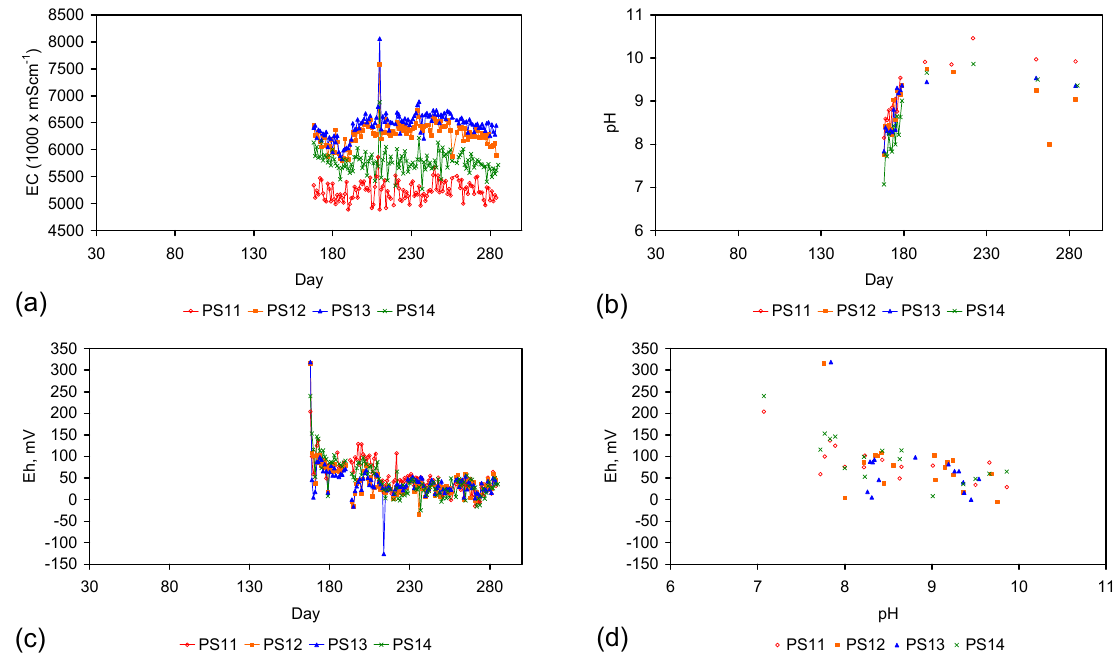
Figure C2. ( a ) EC vs. day; ( b ) Eh vs. day; ( c ) pH vs. day; ( d ) pH vs. Eh; ZVM TP = particulate material placed in water at a concentration of PS5 = 30 g·L − 1 ;